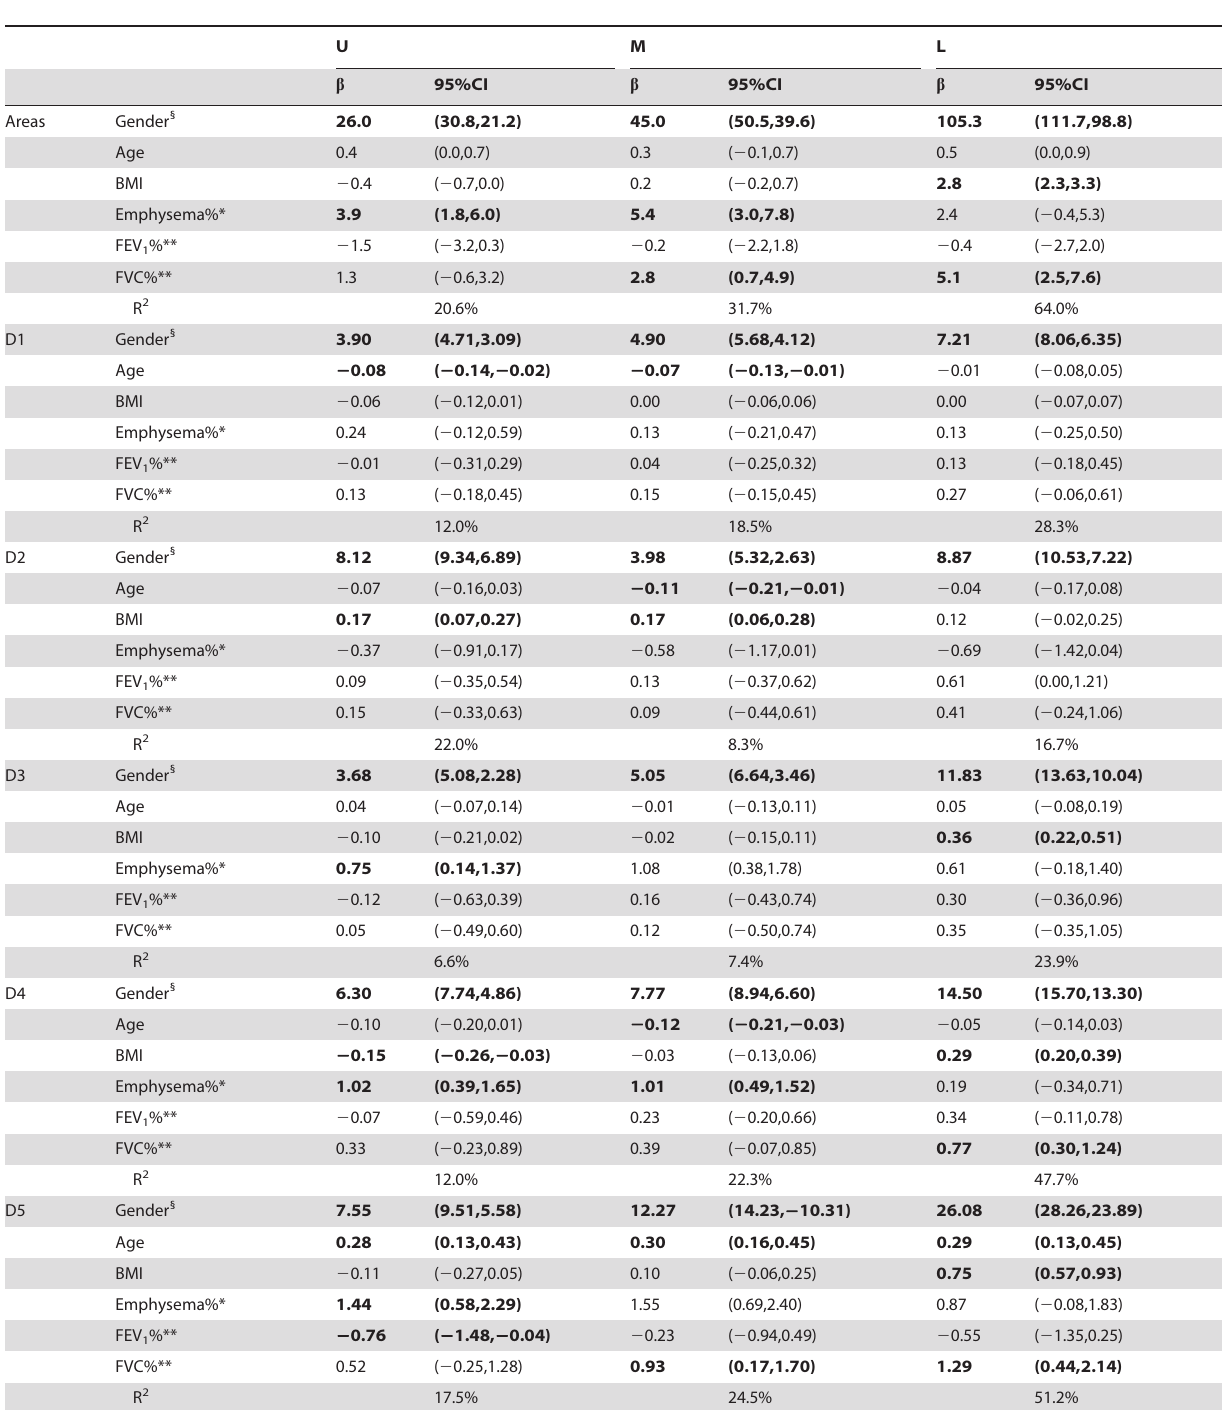
Table 3. Partial regression coefficient ( b ) and 95% confidence intervals (95%CI) of area variation at different lung sections by selected